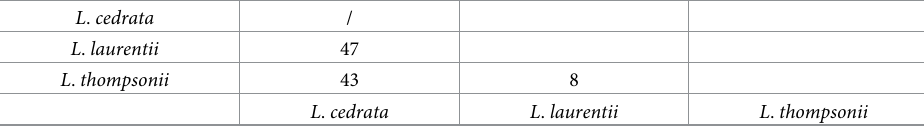
Table 12. SNPs variations in the ETS region among Leplaea